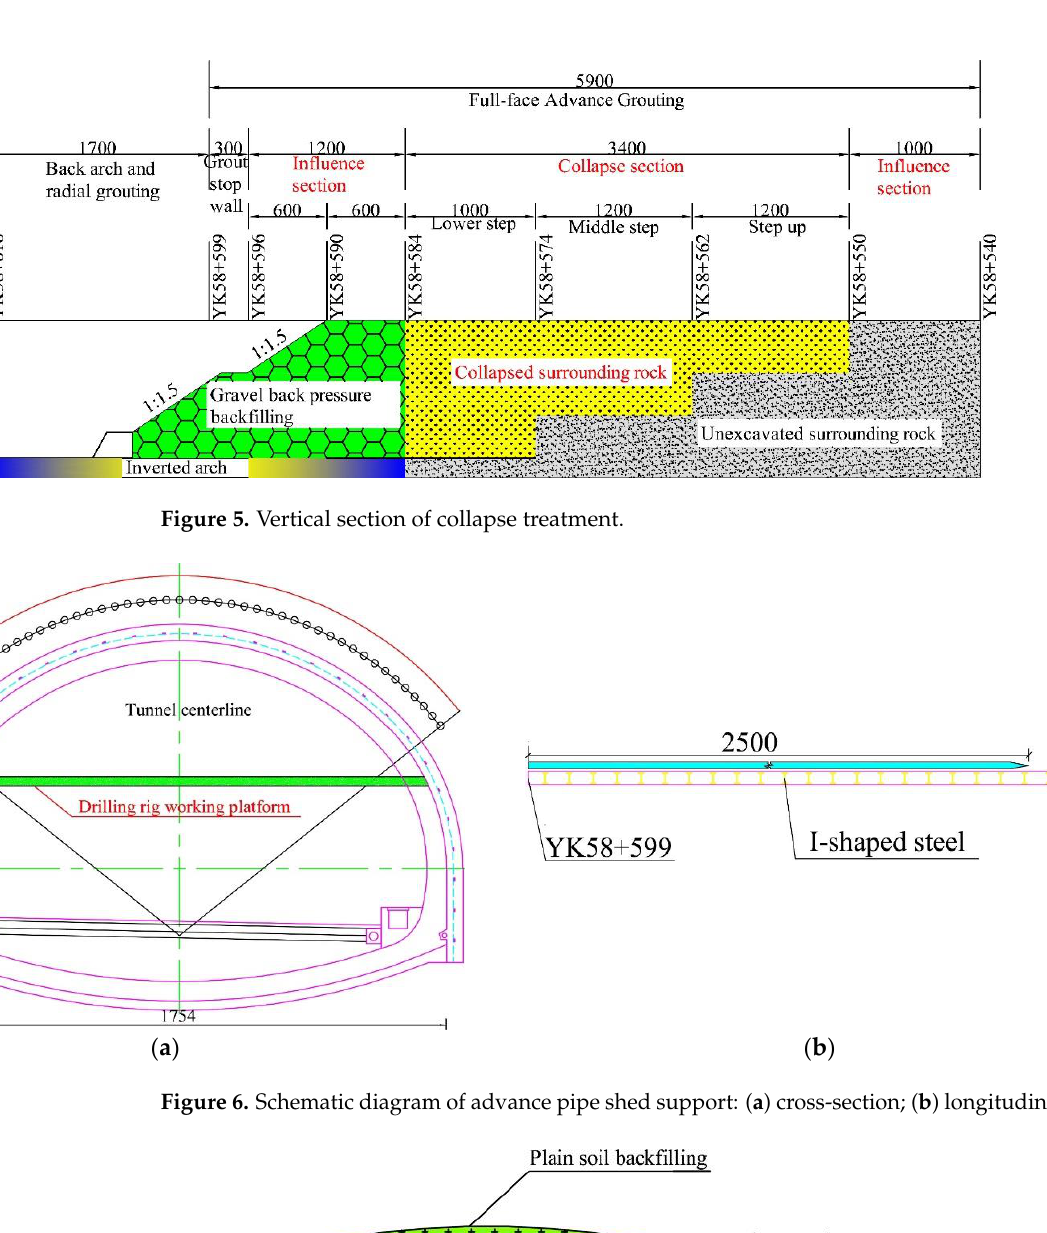
Figure 5. Vertical section of collapse treatment.